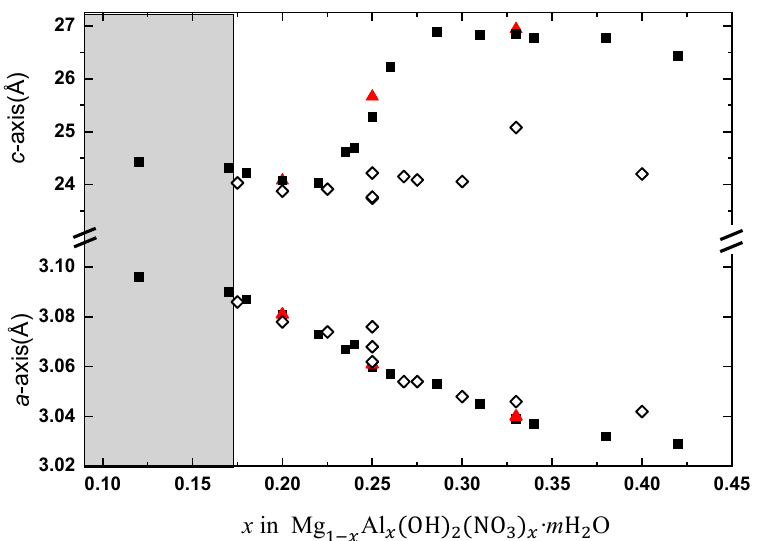
Figure 1. Variation of the a - and c -axis with x , Al(III) content, for as-synthesized ( (cid:4) ) and post hydrated ( (cid:78) ) Mg 1 − x Al x (OH) 2 (NO 3 ) x · m H 2 O layered double hydroxides (LDHs) synthesized at pH 10.0. ( ) represent synthesis at pH 11.0. Gray shading indicate range where additional diffraction peaks prove lack of phase purity, see text.